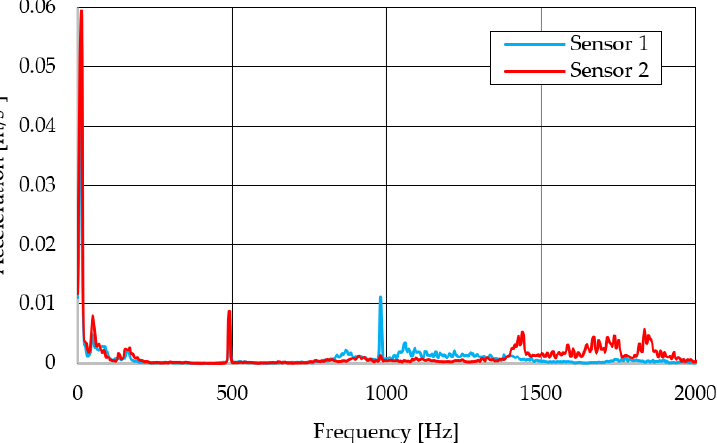
Figure 17. Comparison of the frequency waveforms in the x -axis during symmetrical crossing over the obstacles.